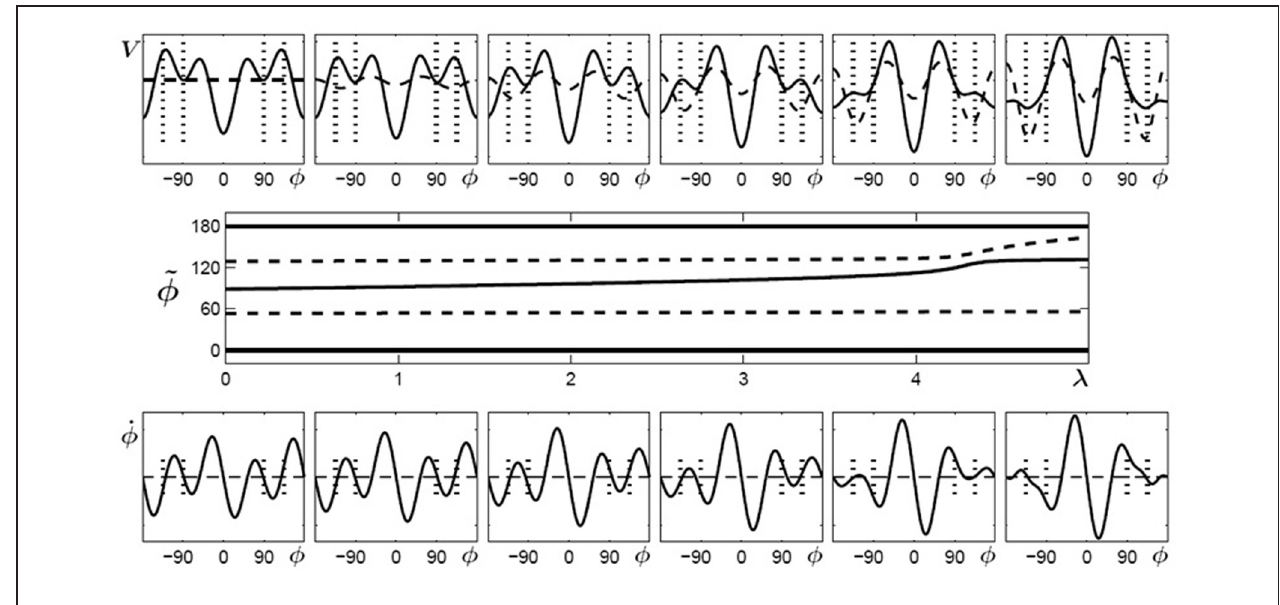
eventually leading to an attractor close to the required phase of ψ = 135 ◦ (only the upper half of the bifurcation diagram is shown because the part for negative values of φ is symmetric).